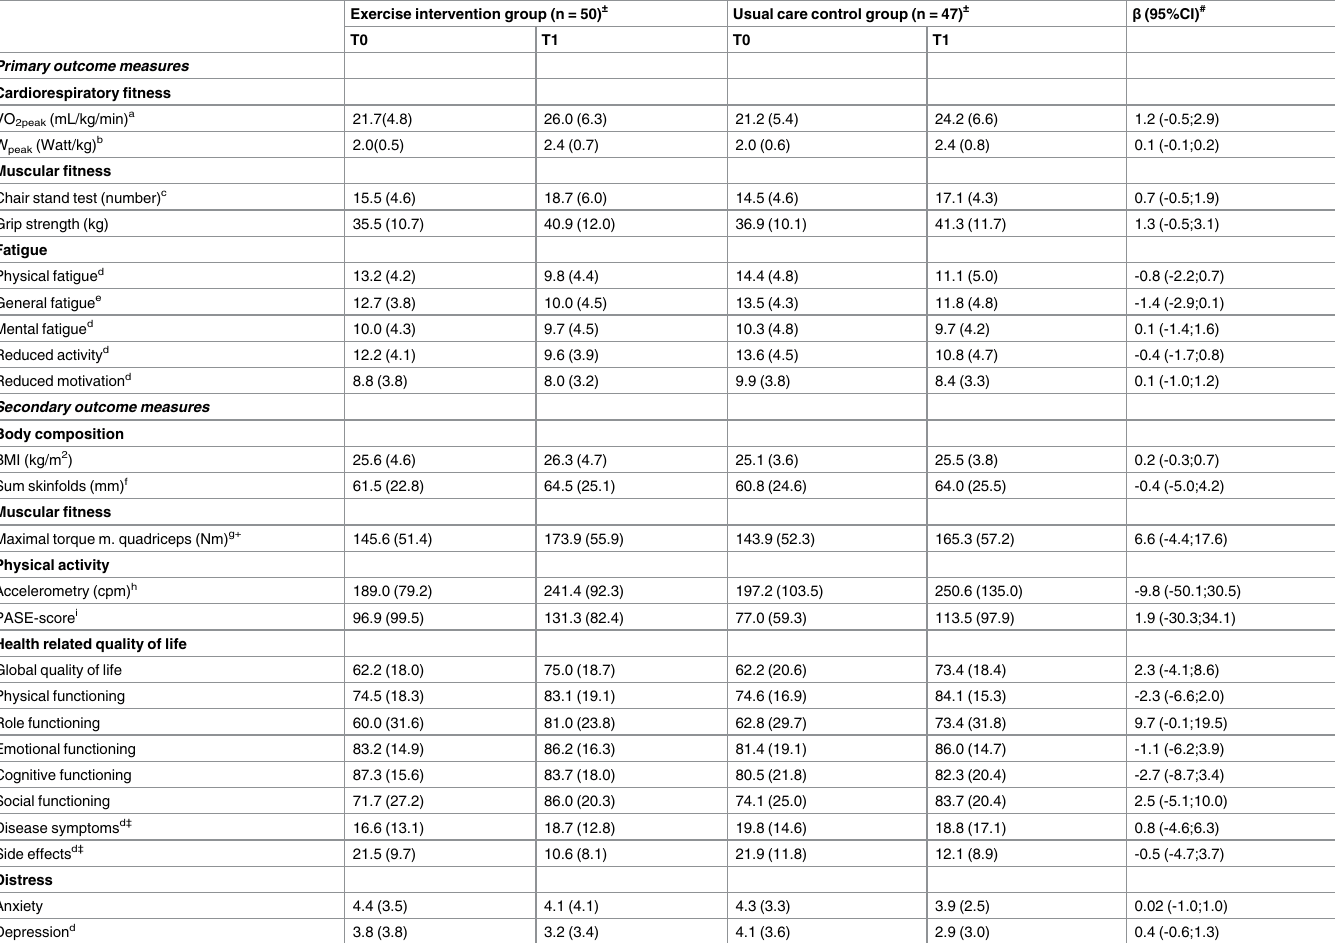
Table 2. Effects of the intervention on primary and secondary outcome measuresin patients treated with